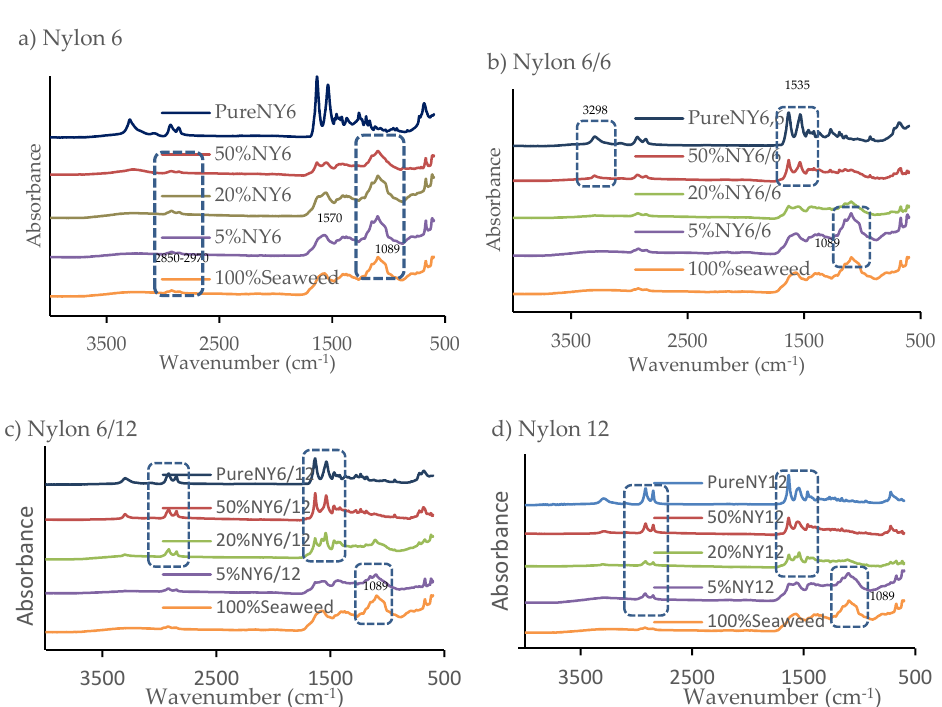
Figure 3. Fourier transform infrared (FTIR) analysis of pure nylon and the solid phase from hydrothermal coliquefaction of F. serratus with ( a ) nylon 6, ( b ) nylon 6/6, ( c ) nylon 6/12 and ( d ) nylon12.